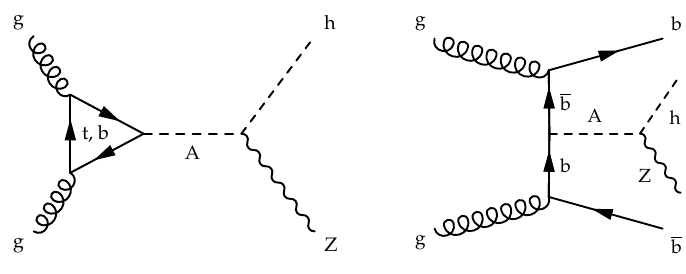
Figure 1 . Feynman diagrams for two dominant production processes for the pseudoscalar A boson: gluon fusion (left) and associated production with b quarks (right). In both cases the A boson decays into a 125 GeV Higgs boson and a Z